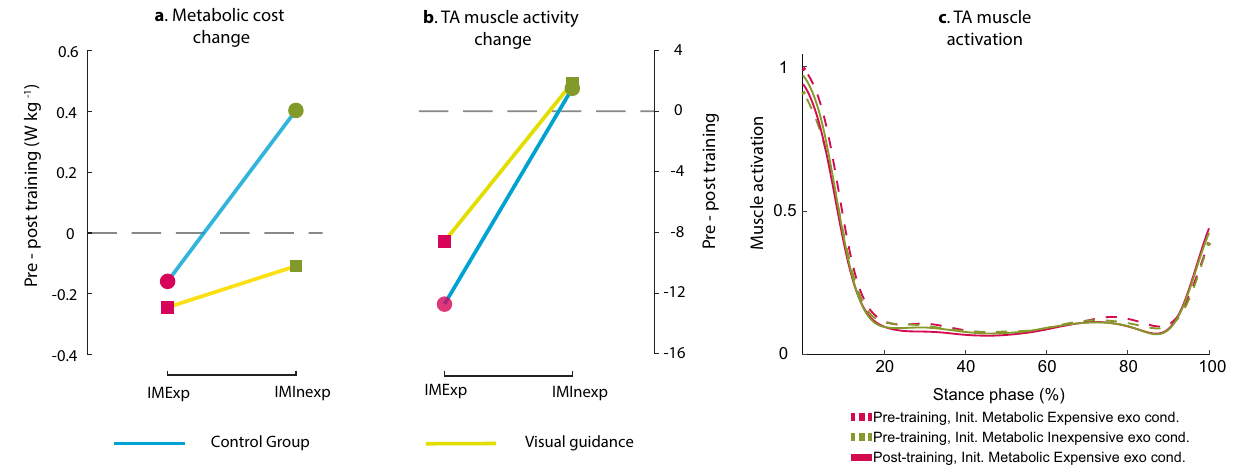
Figure 4. Effects of training methods (Control, and Visual guidance) and exoskeleton conditions (IMExp, IMInexp) on change in ( a ) Metabolic cost and ( b ) TA muscle activity. ( c ) TA muscle activation during the stance phase. Both training methods helped to change in metabolic cost and TA muscle activity (Pre-Post training) for the Init. Metabolic Expensive (IMExp) condition compared to the Init. Metabolic Inexpensive (IMInexp) condition. The Visual guidance helped to change in metabolic cost, compared to the Control